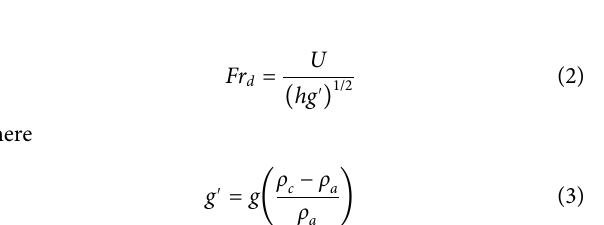
FIGURE 4 | Slope extent comparison for each of the deposits showing the similarity between each deposit. The pinch-out line is at 2 cm due to the dif fi culty in tracing accurately around the 2 cm line because of water-ponding in the drained tank.